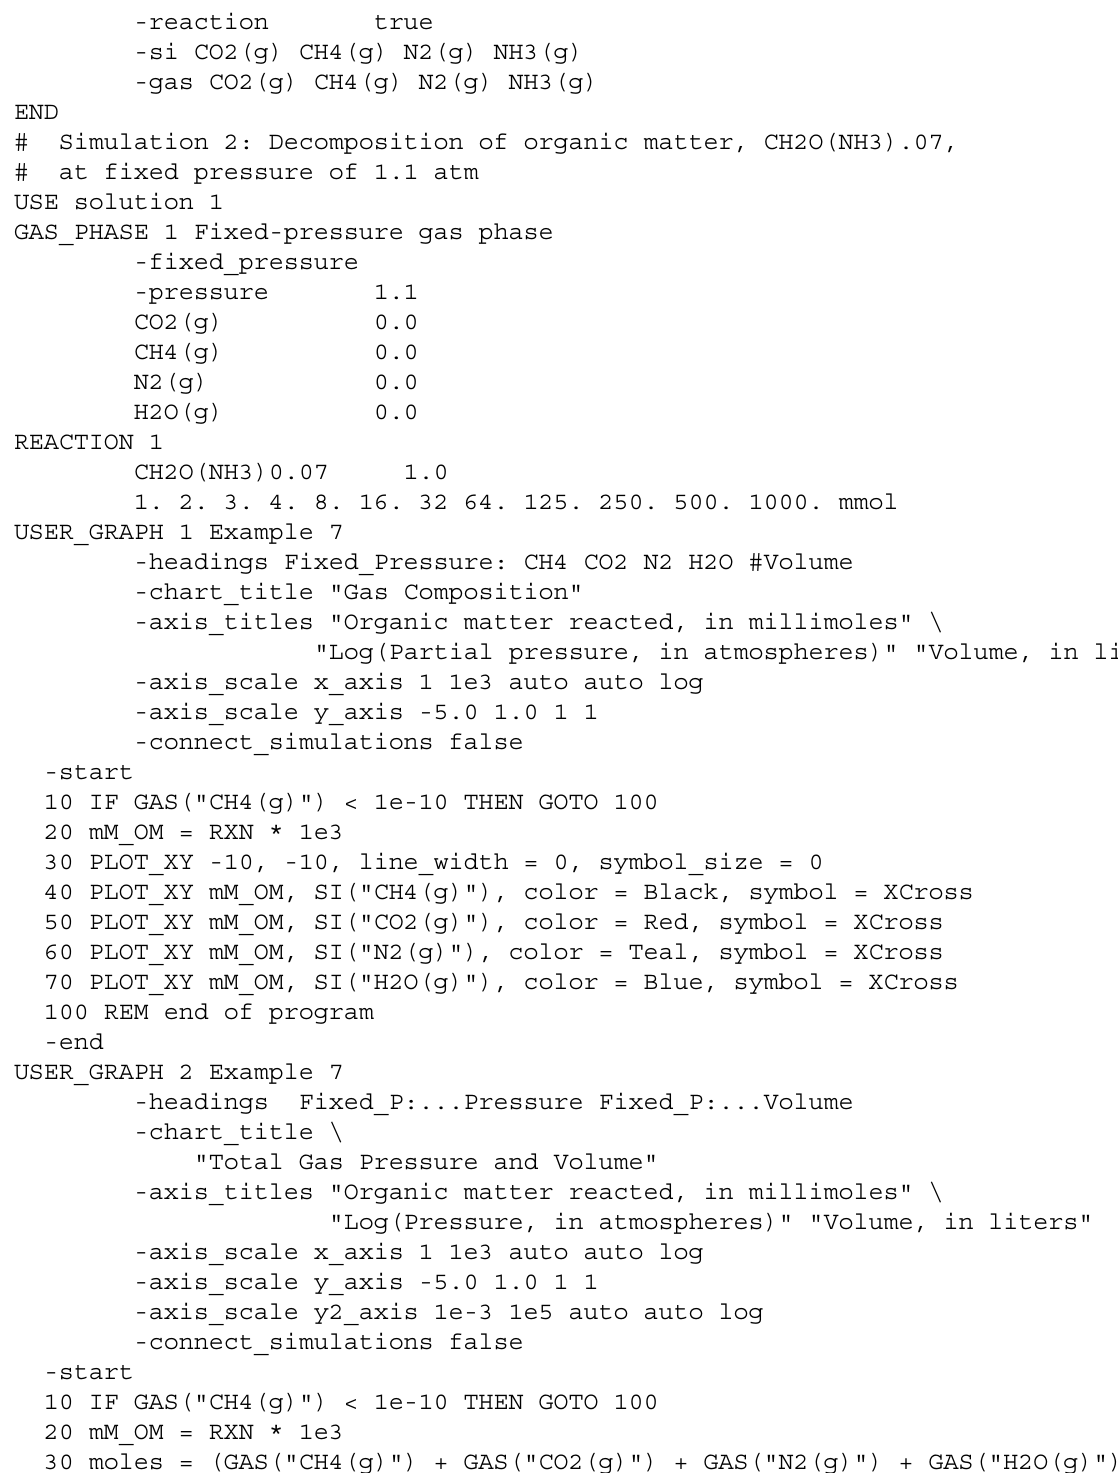
Table 26. Input file for example 7.—Continued -reaction